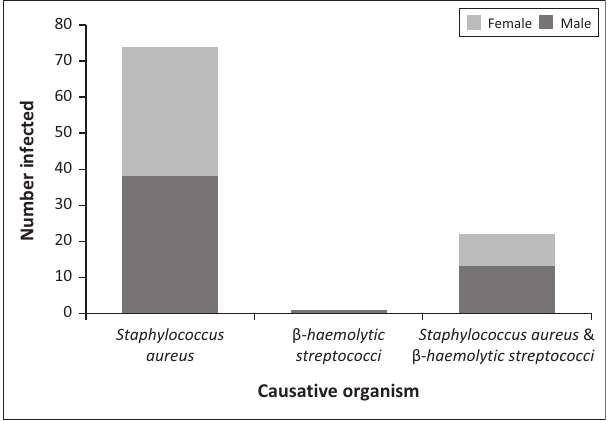
FIGURE 1: Causative organisms of secondary TABLE 2: Antibiotic susceptibility pattern of isolated bacteria from skin swab culture. Isolate ( N )